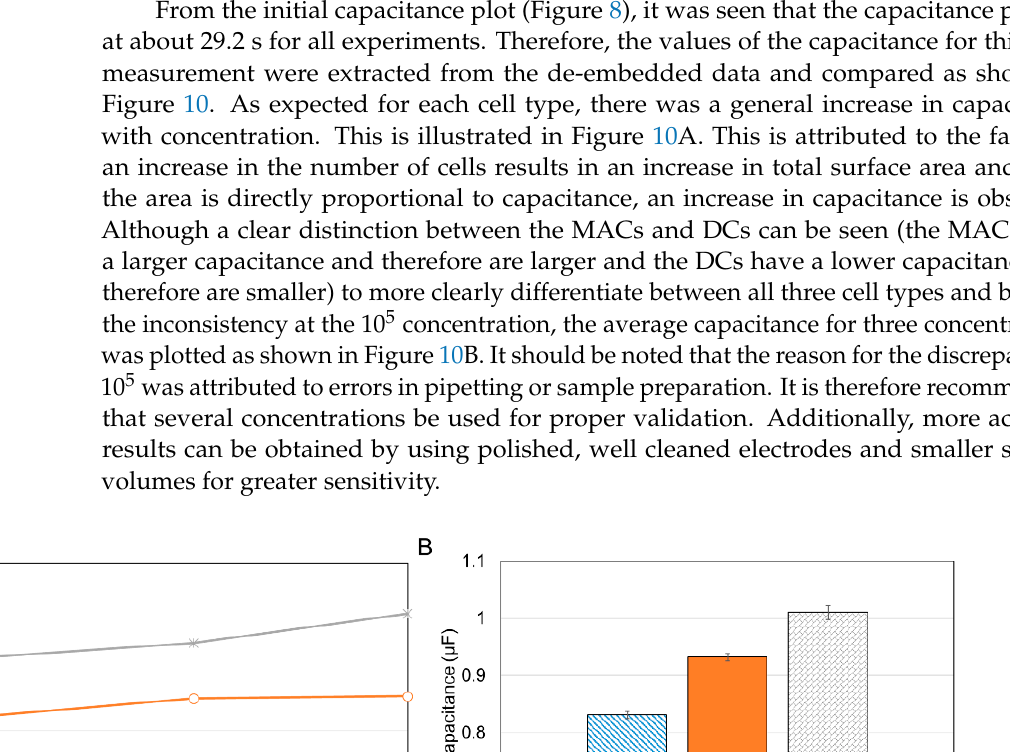
Figure 9. Capacitance–time curve for the three types of cells after media de-embedding ( A ) THP-1, ( B ) DCs, ( C ) MACs. De-embedding was performed by diving each of the concentration values in Figure 8 by their corresponding media value.